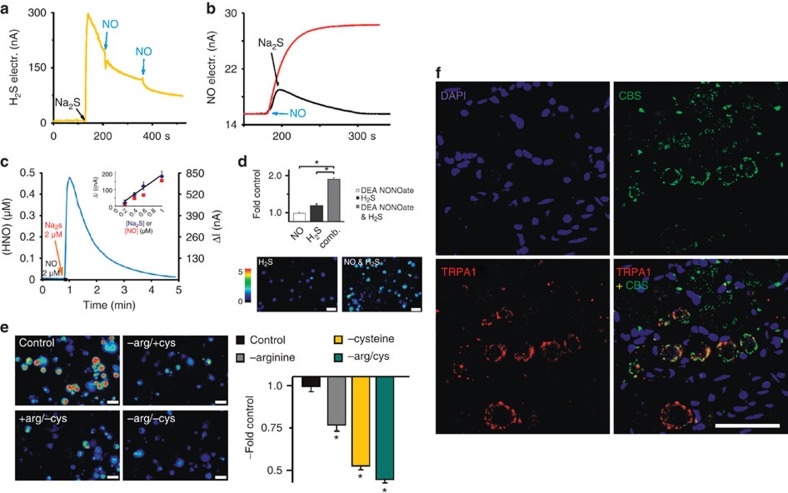
HNO formation is NO and H2S dependent.(a,b) H2S and NO react in vitro as observed by the drop of H2S electrode response upon subsequent additions of NO solution (a) and by the drop of NO electrode response when H2S was injected into solution containing DEA NONOate (b). (c) Amperometric signal of the HNO-selective electrode after addition of H2S (2 μM) to a solution of 2 μM NO (left axis: (HNO) after calibration, right axis: measured current). Inset: Signal peak versus H2S (blue) and NO (red) concentration, while the other reactant concentration is maintained constant and in excess. (d) Treatment with DEA NONOate (100 μM) and H2S (100 μM) for 15 min increased fluorescence in DRG neurons incubated with CuBOT1. (Analysis of variance (ANOVA) honestly significant difference (HSD) post hoc test; P<0.001, respectively, n=116 each, scale bar, 80 μm). (e) Basal fluorescence of the HNO sensor in sensory neurons was reduced by arginine and cysteine depletion, substrates for endogenous NO and H2S production (ANOVA HSD post hoc test; *P<0.001, treated versus control respectively; n=150; all error bars represent s.e.m., scale bar, 50 μm). (f) Confocal images of a rat trigeminal ganglion section immunohistochemically double stained with antibodies against TRPA1 (Cy3, red) and CBS (FITC, green) combined with nuclear 4′,6-diamidino-2-phenylindole hydrochloride (DAPI) staining (blue; scale bar, 50 μm).